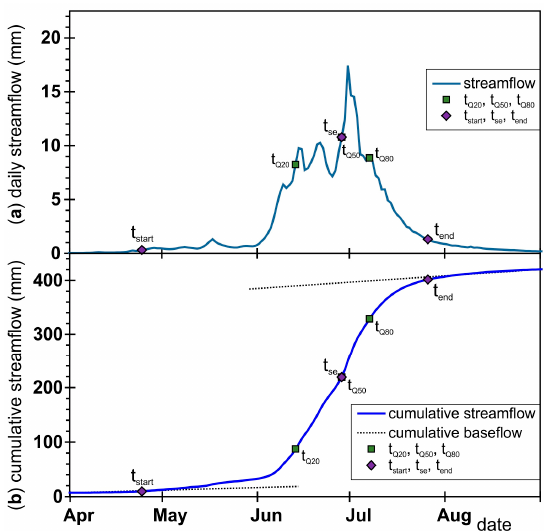
Figure 1. Example year of ( a ) streamflow data and ( b ) cumulative streamflow and cumulative baseflow illustrating the dates derived from the new method (t start , t se , and t end ) versus the COV and other fixed-flow dates (t Q20 , t Q50 , and t Q80 ).